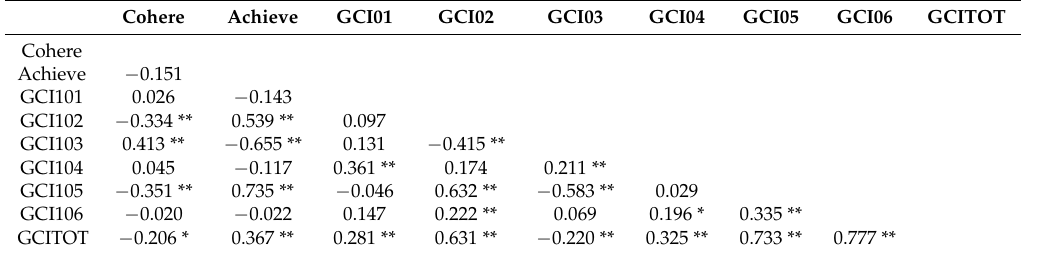
Table 2. Inner Balance app and Global Coherence sites Spearmen correlation